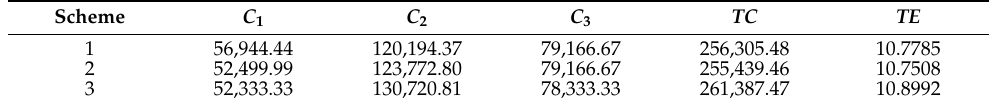
Table 8. Cost breakdown of each